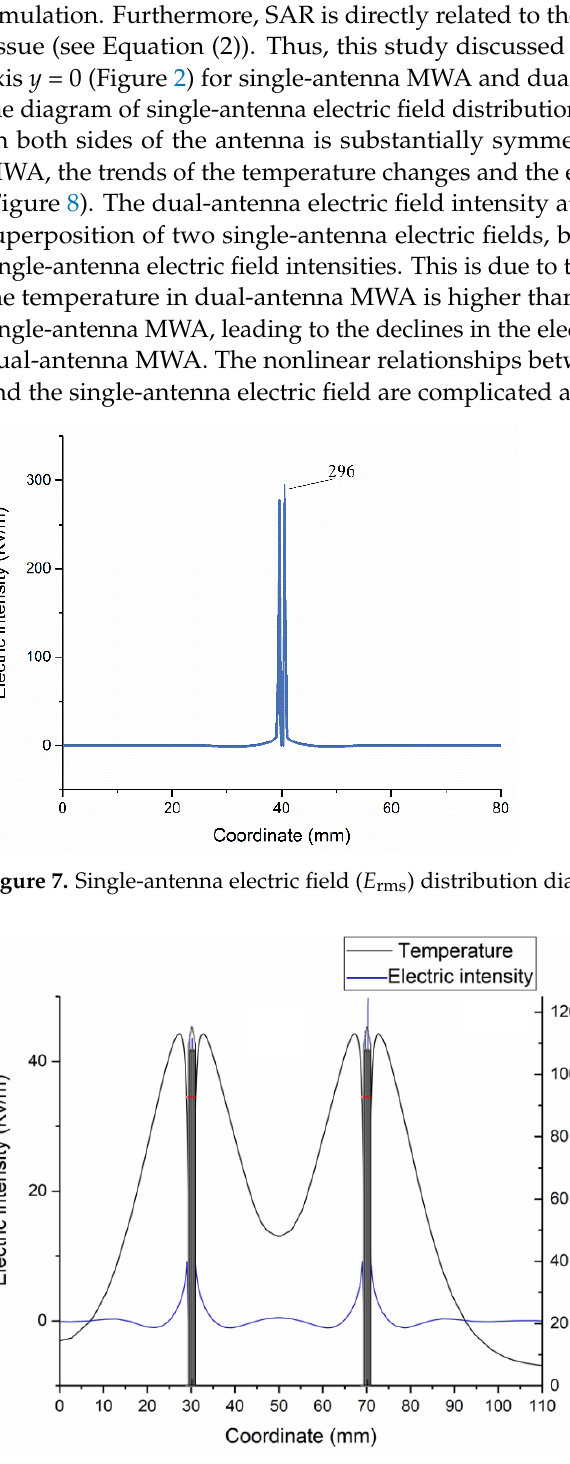
Figure 8. Electric field (E rms ) and temperature distribution diagram in dual-antenna MWA.